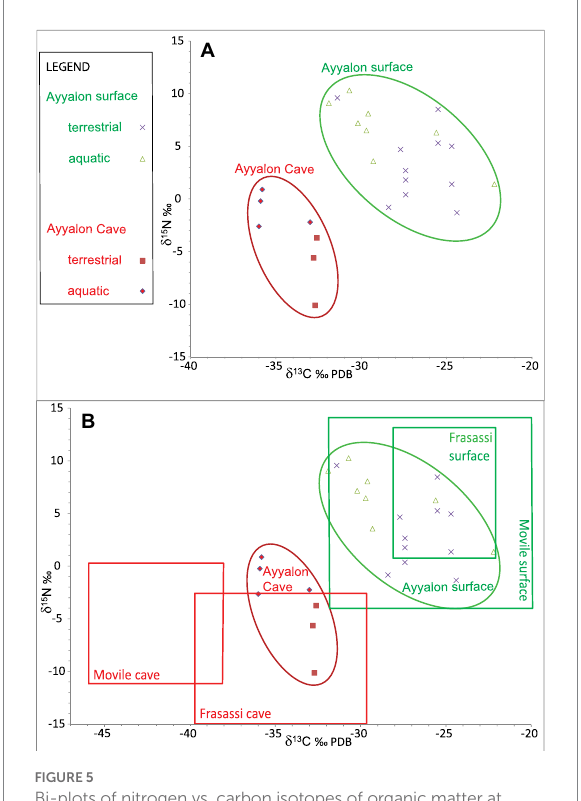
FIGURE 5 Bi-plots of nitrogen vs. carbon isotopes of organic matter at Ayyalon (present study), compared with previously studied caves. (A) from Ayyalon cave (red) and surrounding surface (green), divided to terrestrial and aquatic ecosystems. Cave and surface values fall in distinctively different fields: Organic matter in the cave is much lighter isotopically than respective surface values. Higher trophic levels generally fall to the right of their food source. Further details on individual samples are given in Table 4. (B) comparison between Ayyalon’s data (ellipses) and general fields of similar measurements in two other sulfidic cave ecosystems and their surficial counterparts (rectangles): Movile, Romania (Sarbu et al., 1996) and Frasassi, Italy (Sarbu et al., 2000). The distinctive isotopic depletion is shared by the three caves, suggesting similar controlling factors, with local variations in